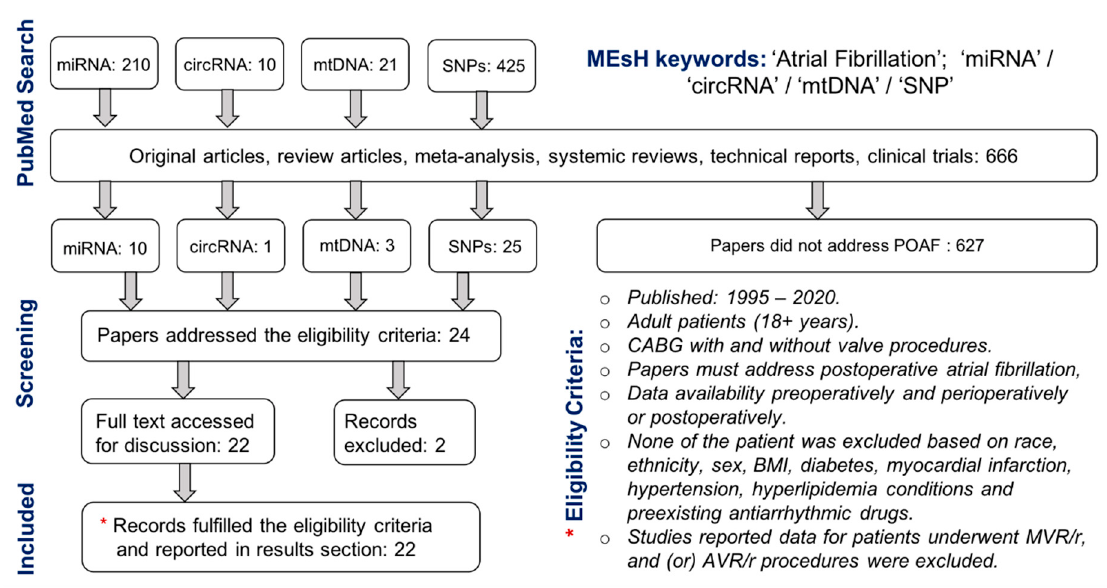
Figure 1. Flow diagram of selected studies searched and reported in this narrative review.